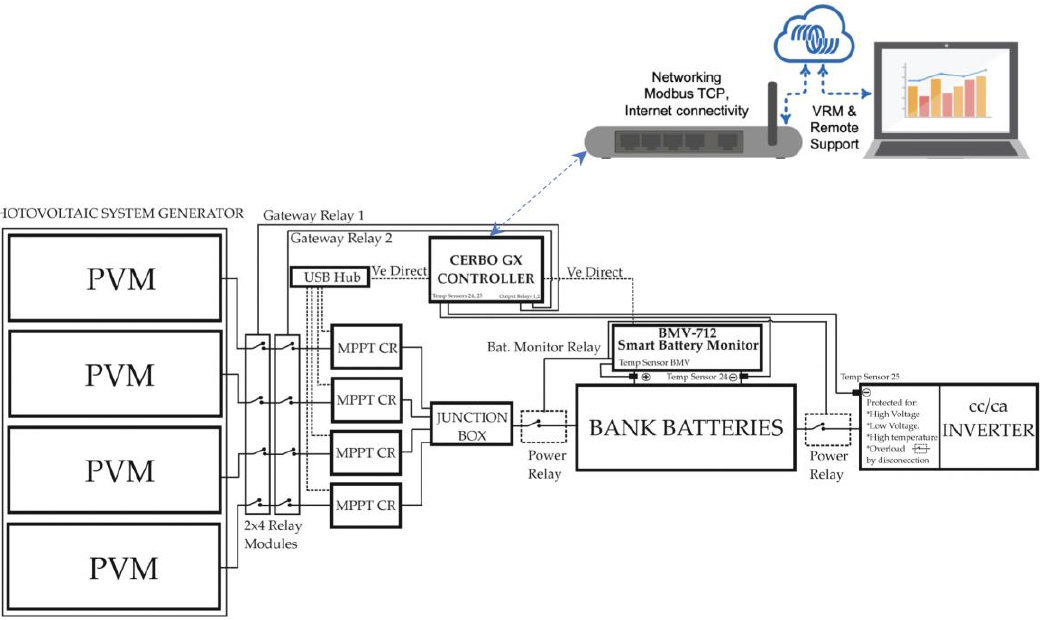
Figure 1. Photovoltaic generation system with integrated and distributed smart BMS system.